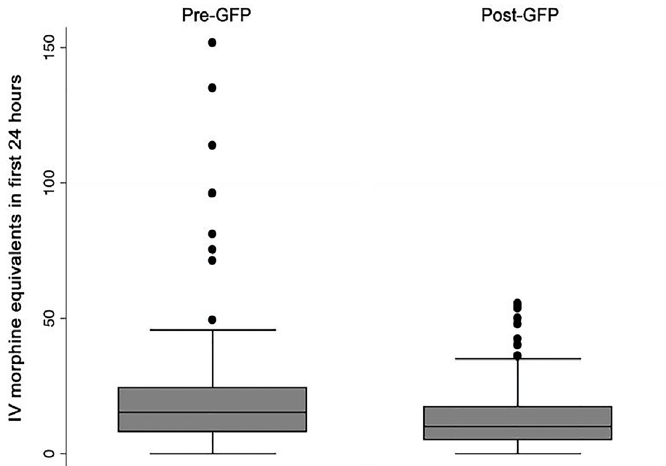
Figure 2. Intravenous (IV) morphine equivalents (mg) before and after implementation of a geriatric fracture program